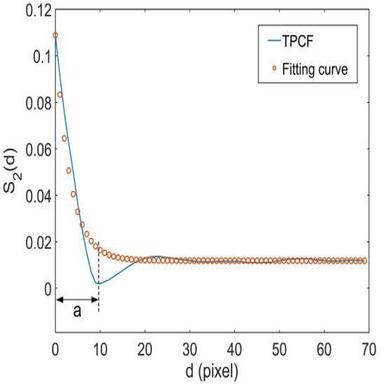
Two-point correlation function and its fitting curve.